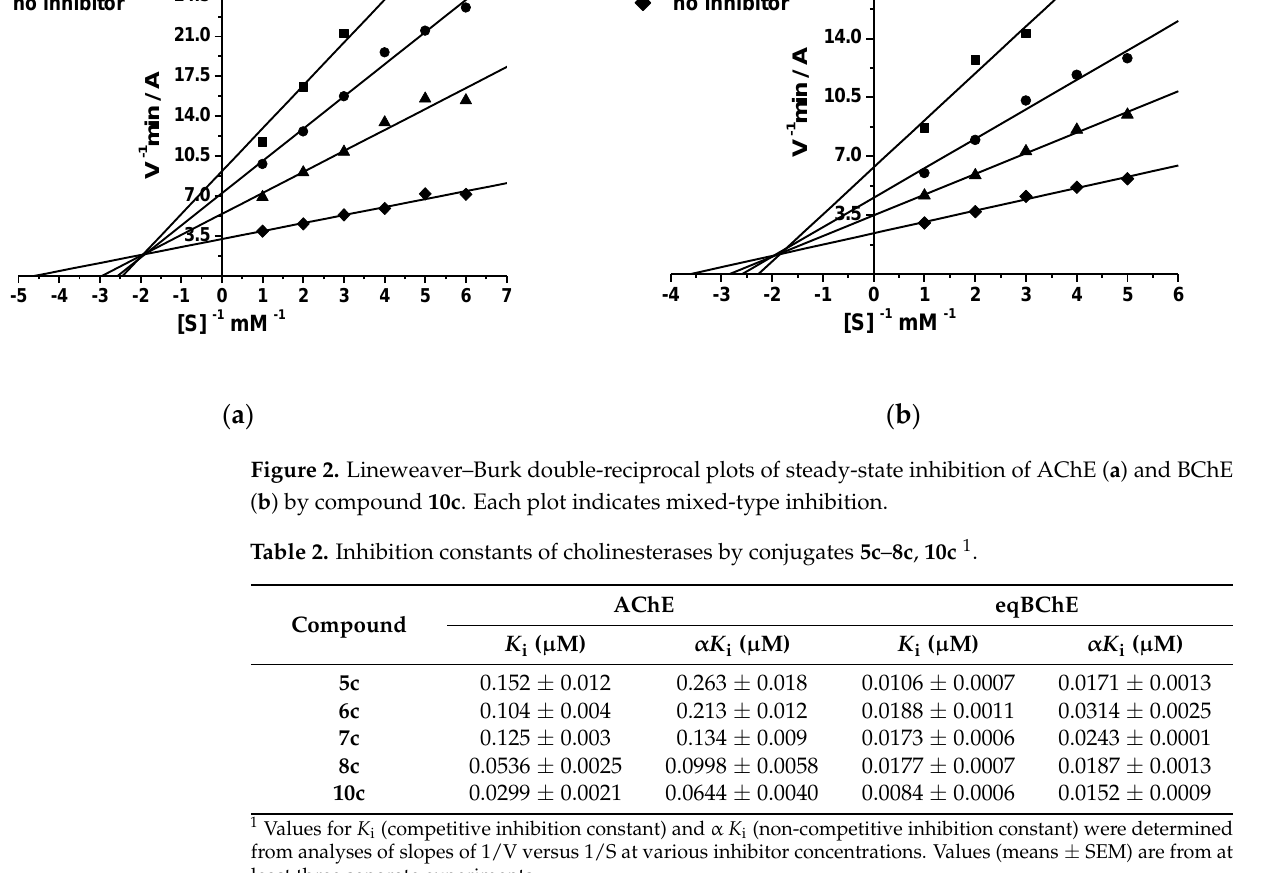
least three separate